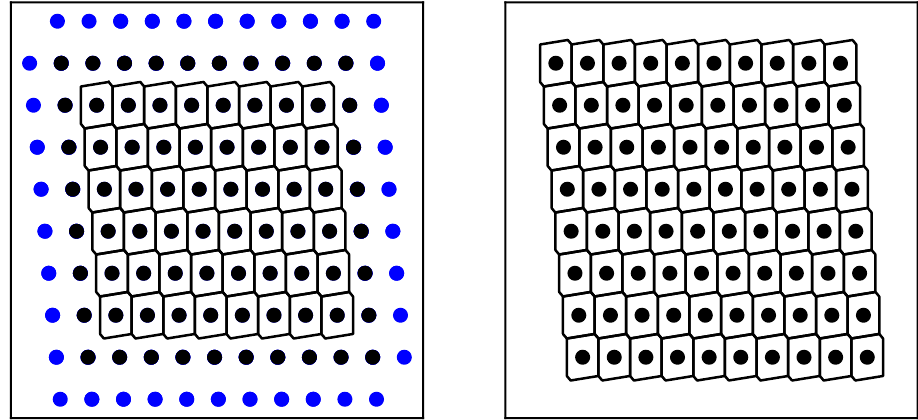
Figure 2. Voronoi tessellation of the Horns Rev wind farm showing wind turbine locations (black dots), ghost point locations (blue dots), and Voronoi cells (black lines). The left panel shows the original tessellation with ghost point projections. The right panel shows the final tessellation with the ghost points removed.